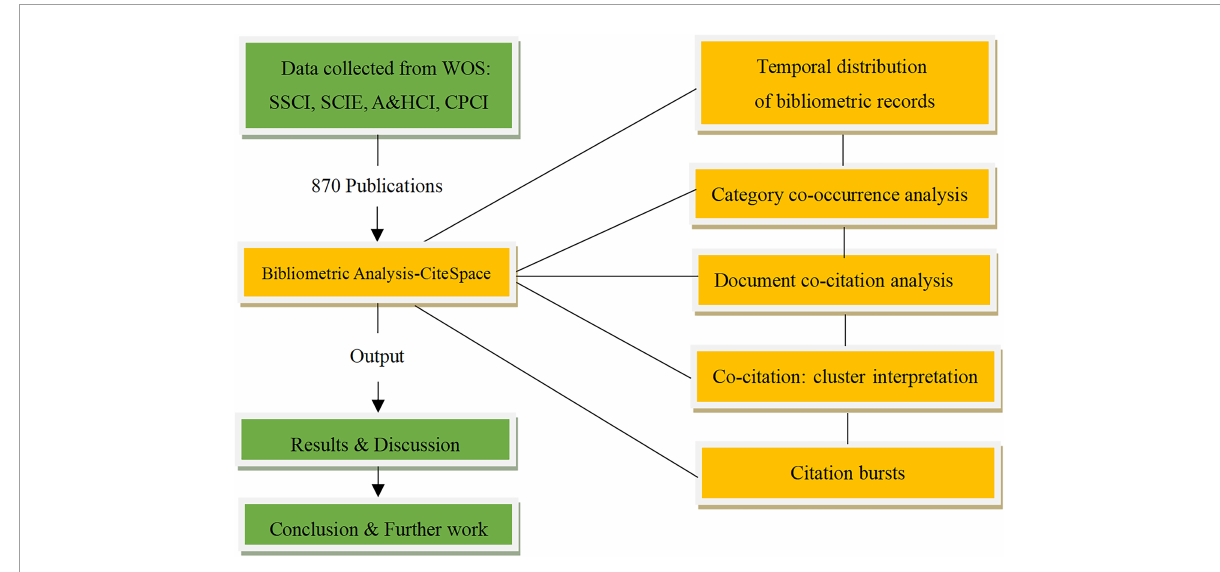
FIGURE1 Processes of financial decision-making bibliometric records